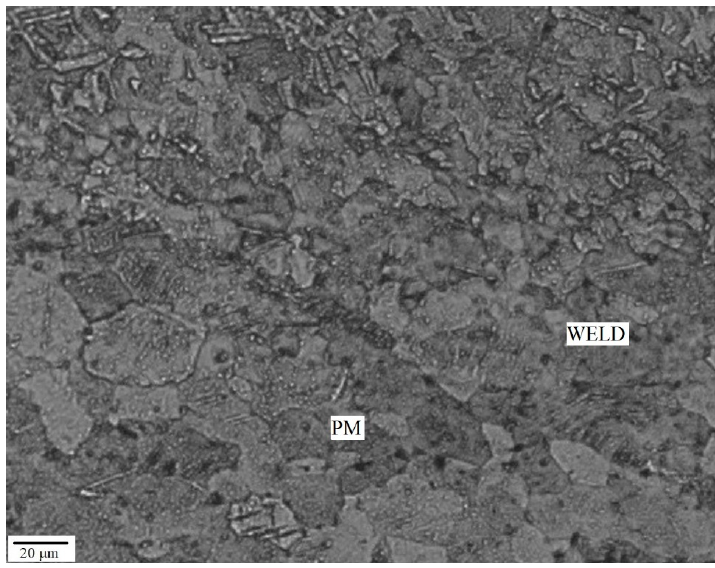
Figure 5. The interface between the PM and the weld. Figure 6a–c depict three microhardness profiles taken across the weld at depths of 0.6, 1.6, and 2.4 from its upper surface, respectively. All the measurements were taken across the stir zone and the adjacent zones, perpendicular to the longitudinal axis of the weld, while maintaining a distance of 0.5 mm from one indentation to another. The measurement began and ended at the parent metal.